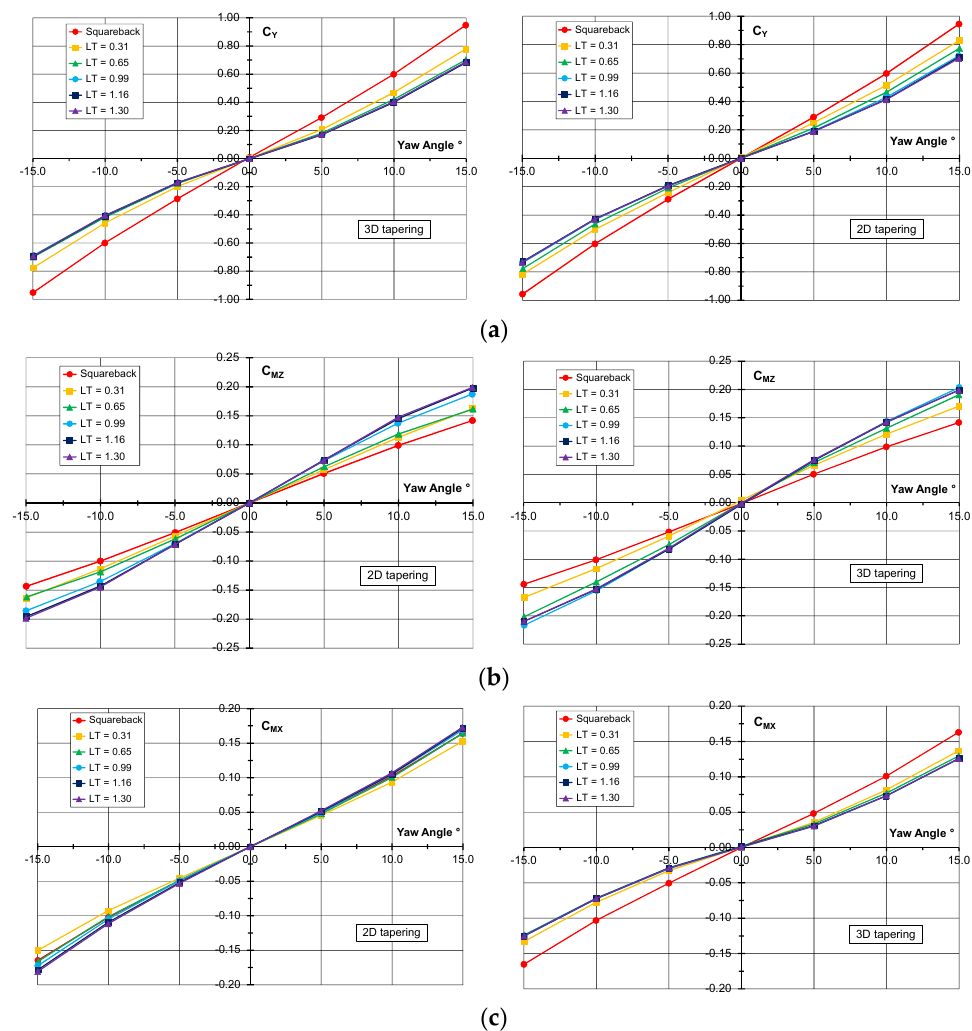
Figure 5. ( a ). Side force coefficient. (Left) 2D tapered body, (Right) 3D tapered body. ( b ). Yawing moment coefficients. (Left) 2D tapered body, (Right) 3D tapered body. ( c ). Rolling moment coefficients. (Left) 2D tapered body, (Right) 3D tapered body.